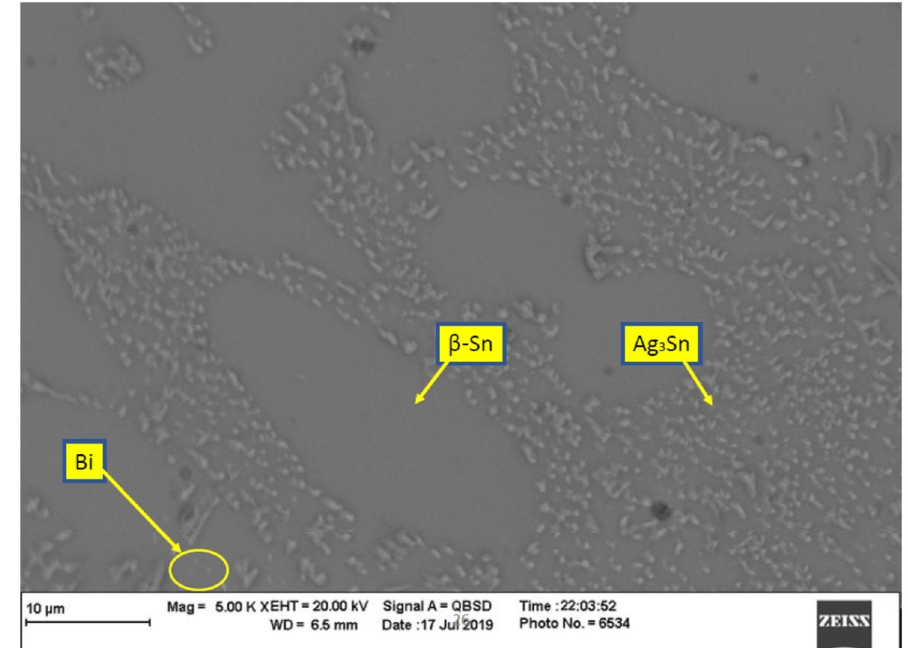
Figure 5. The microstructure of Cyclomax is not subject to thermal aging.